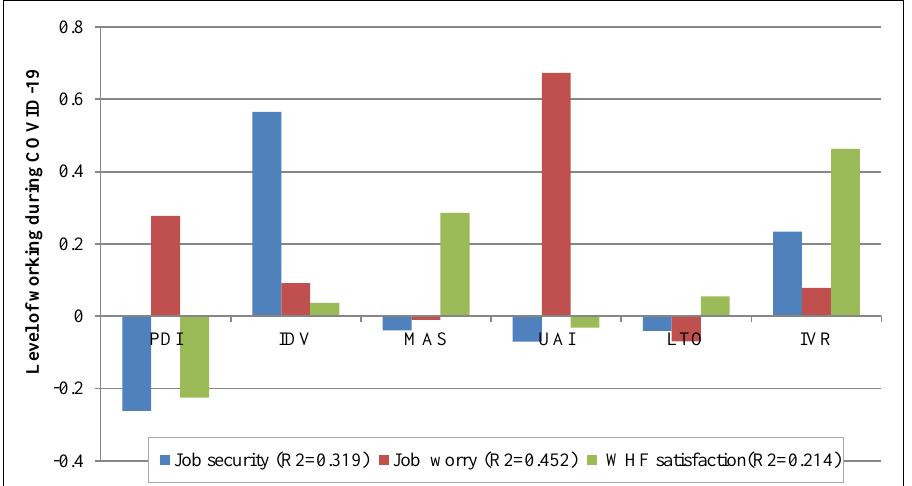
Figure 5. Working during